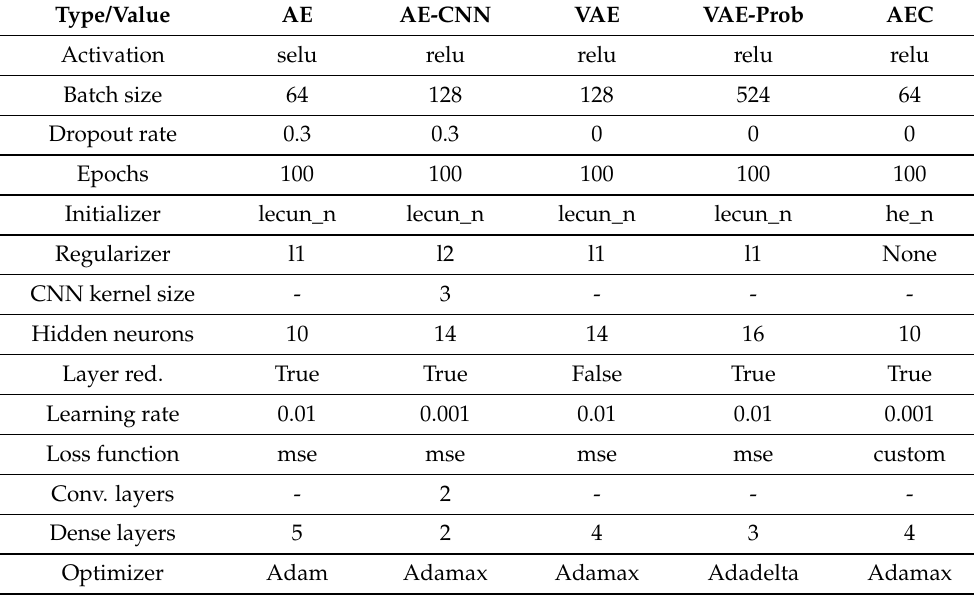
Table 4. Optimised parameters with hyperparameter